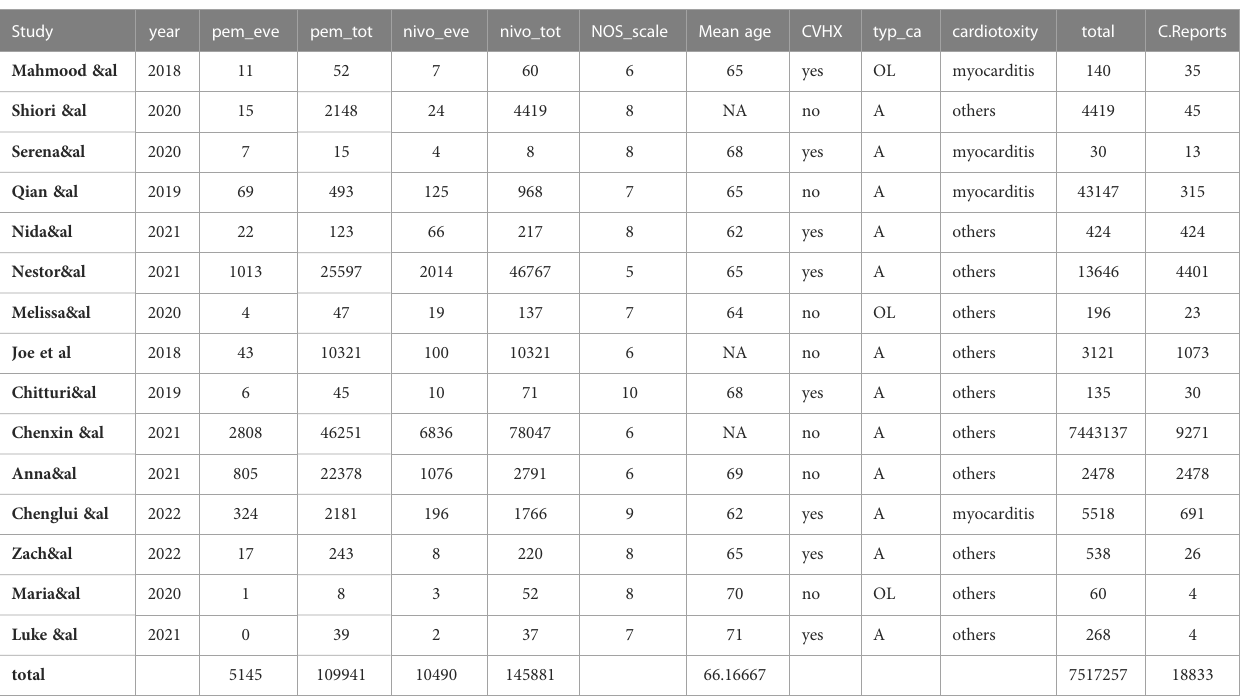
(Figure 3), with considerable heterogeneity (I 2 = 99%, P h = 0.00), showing that the difference between the risk of cardiotoxicity reports between pembrolizumab and nivolumab was not statistically signi fi cant. However, it would be signi fi cant for